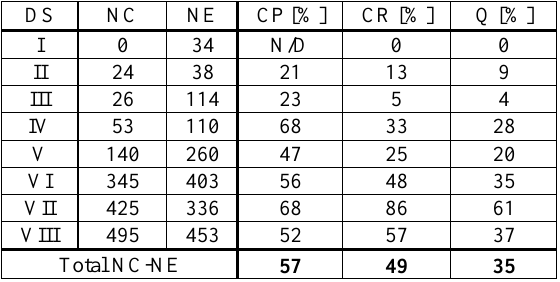
Table 3: Evaluation based on bomb craters (N/D: not defined). DS